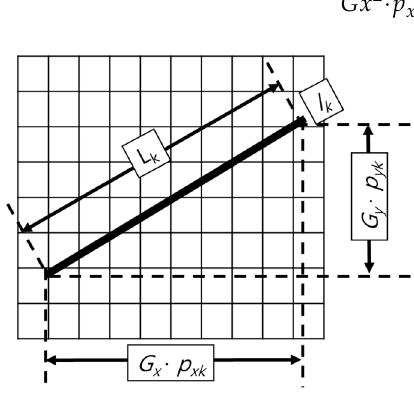
Figure 6. Size of line segment in the image.